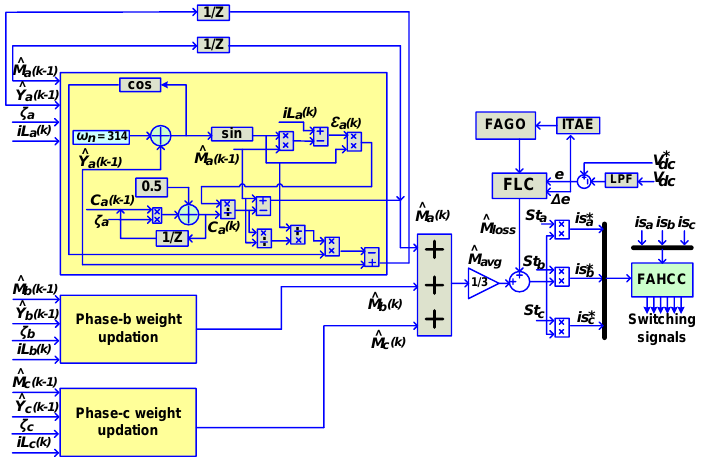
Figure 2. The control block of the proposed MRGN technique, where V ∗ dc and is ∗ ( a , b and c ) are the dc link reference voltage and three phase reference currents respectively.